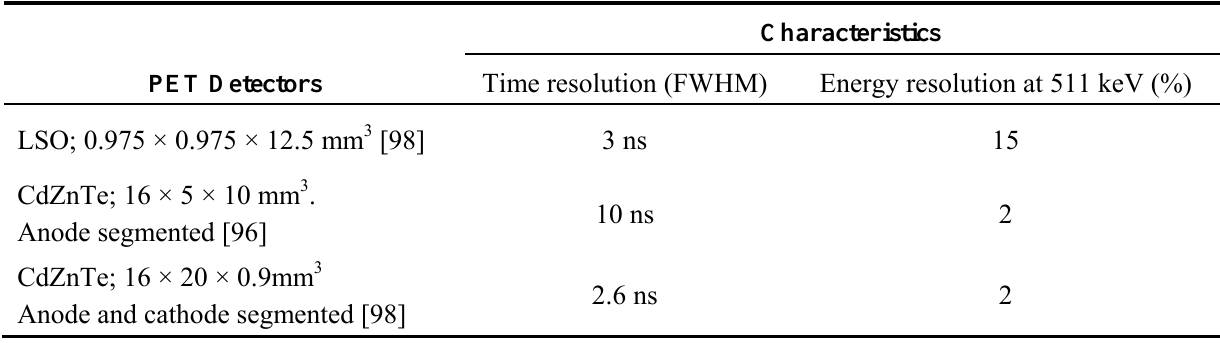
Table 3. Characteristics of PET systems based on LSO and CdZnTe